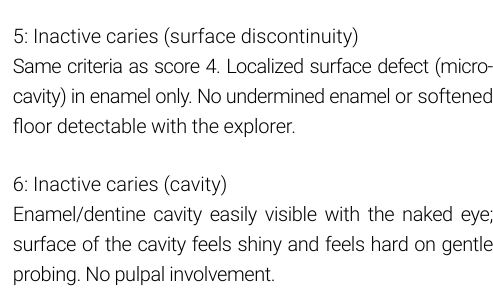
Figure 2. Criteria used in the visual